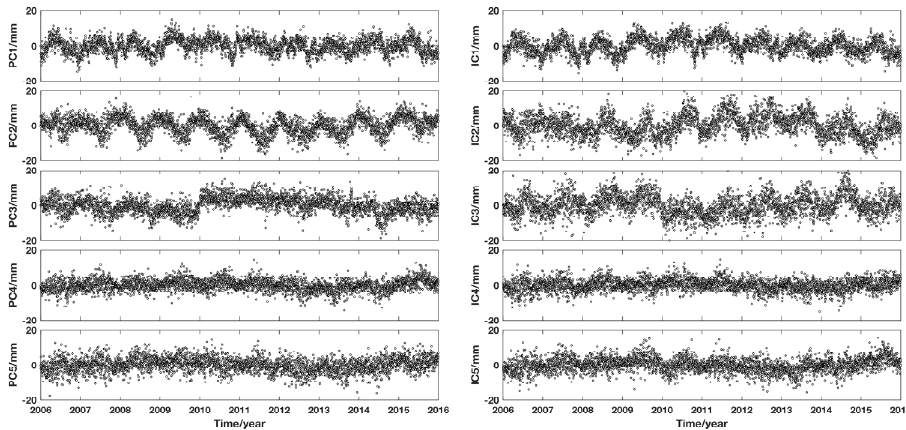
Figure 5. Five components extracted from Taiwan PCA ( left ) and ICA ( right ).